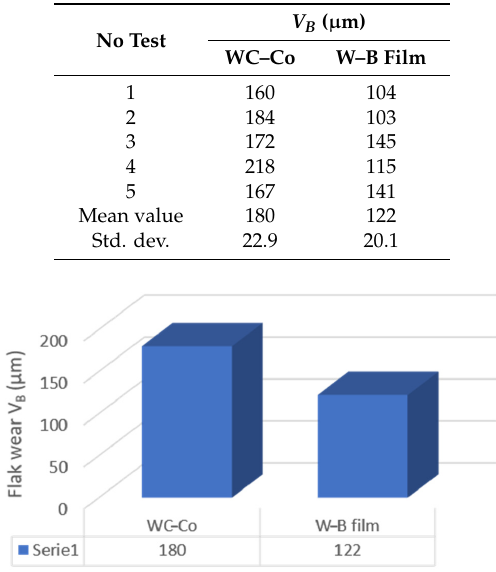
Figure 10. Flank wear V B of cutting edges WC–Co and WC–Co coated with W–B film after turning tests at constant cutting conditions v c = 80 m/min, a p = 1.5 mm, p = 0.09 mm/rev and cutting length 70 mm.